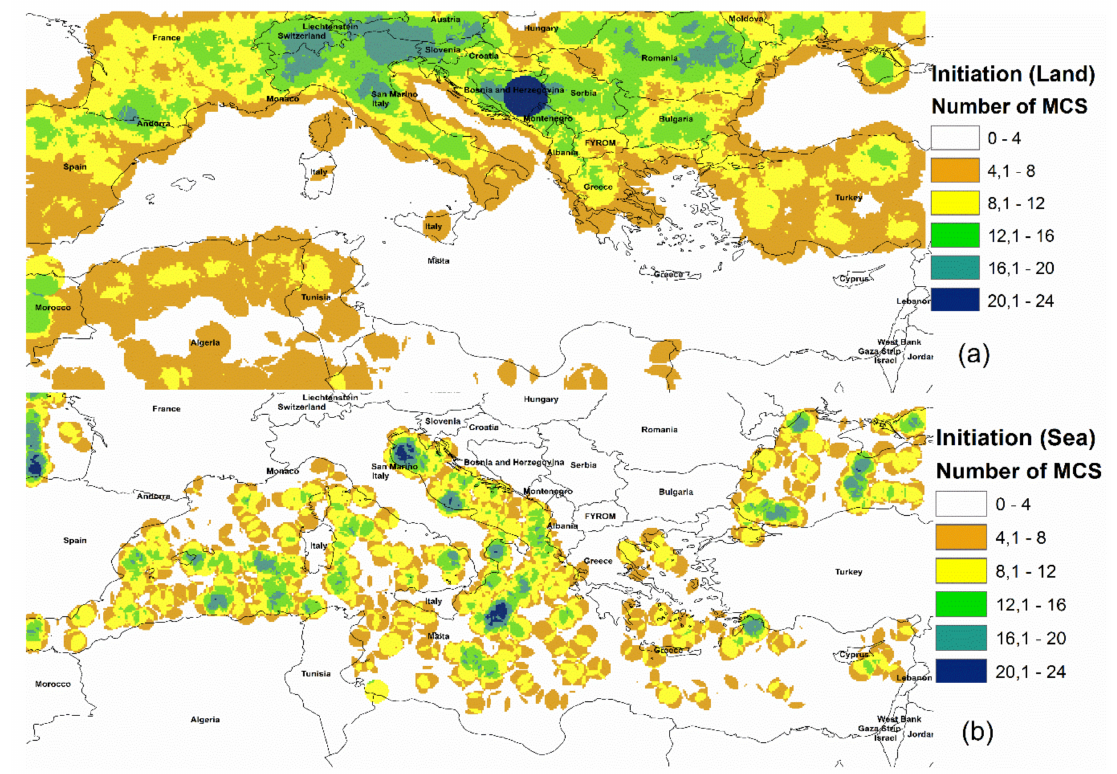
Figure 5. Spatial density of occurrence for the MCSs with at least one CC CClocalmax event that first occurred ( a ) on land; ( b )